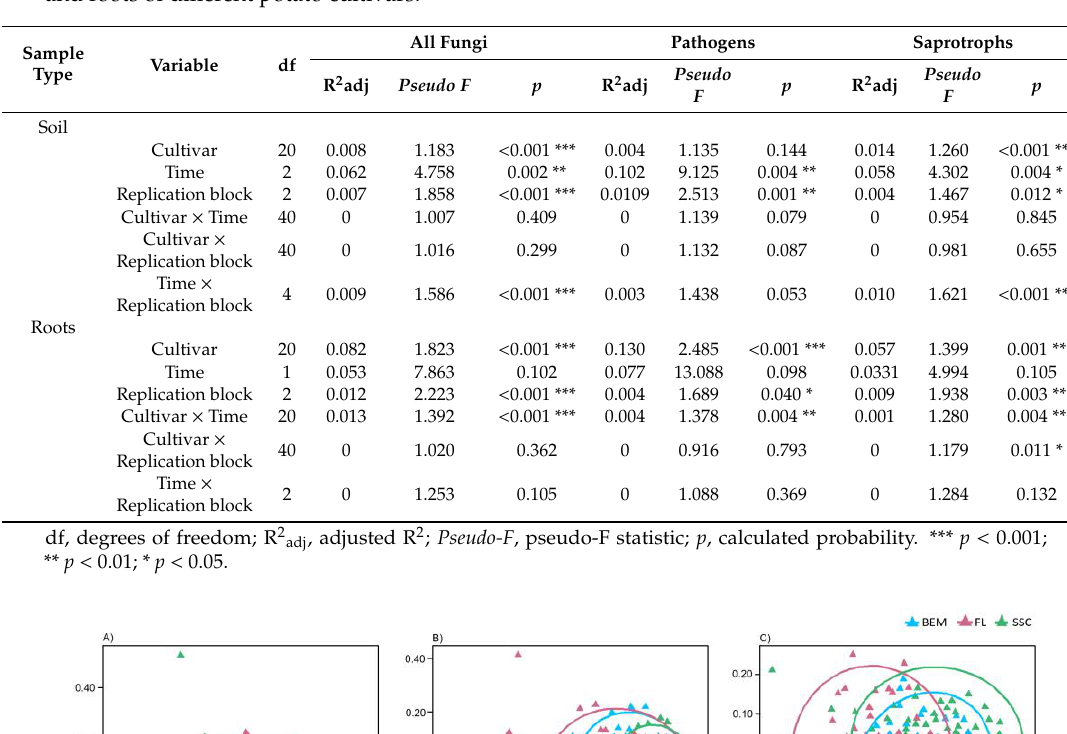
Table 3. Di ff erences in total fungal, pathogenic and saprotrophic community composition in both soil and roots of di ff erent potato cultivars.